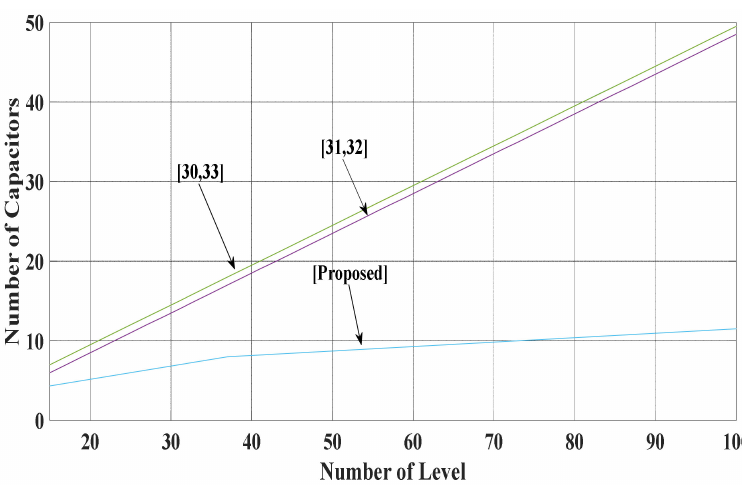
Figure 12. Variation in number of capacitors with number of